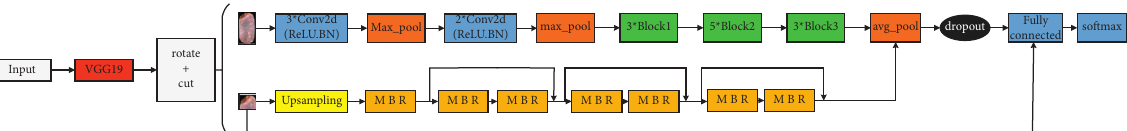
Figure 18: Improved Inception-v3 network structure diagram.